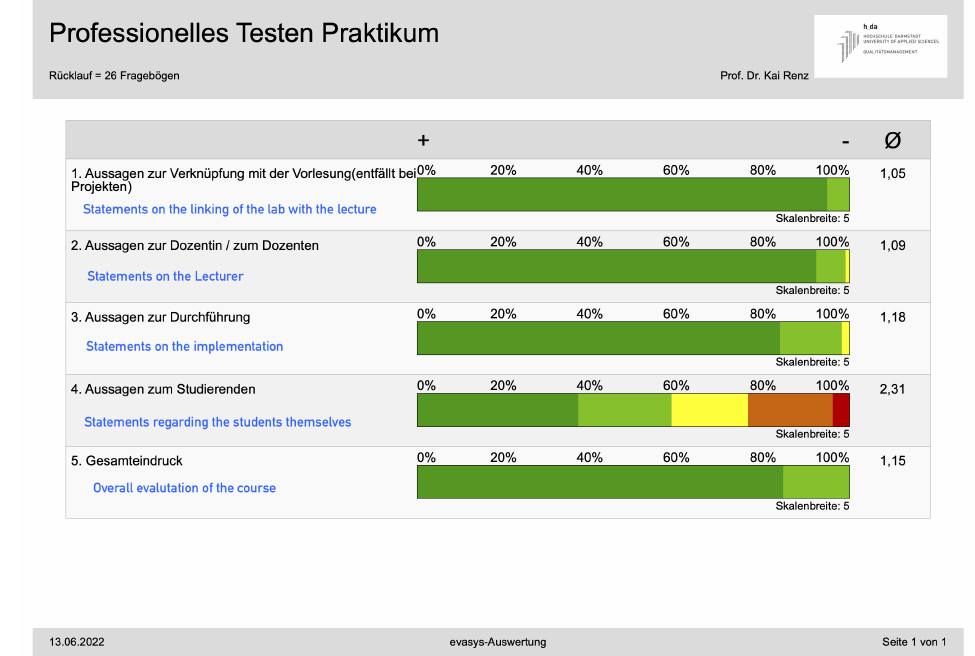
Figure 5. Summary of student evaluation of the